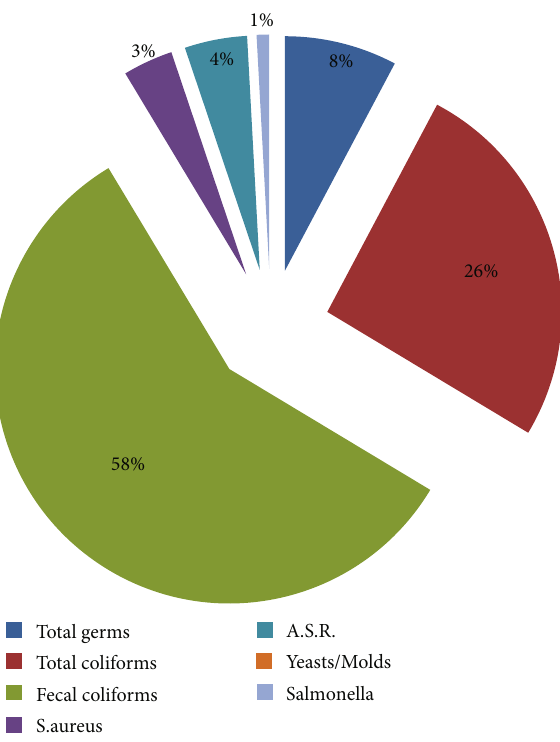
Figure 5: Non-conformity according to the